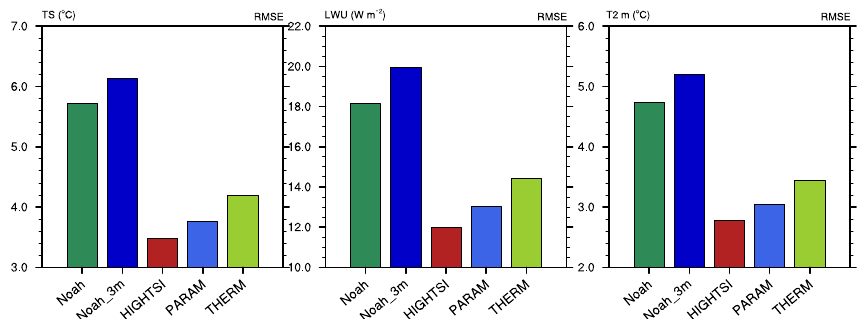
Figure 8. RMSE of surface temperature, upward long-wave radiation and 2m air temperature for WRF-Noah and WRF-HIGHTSI prescribed with different sea ice